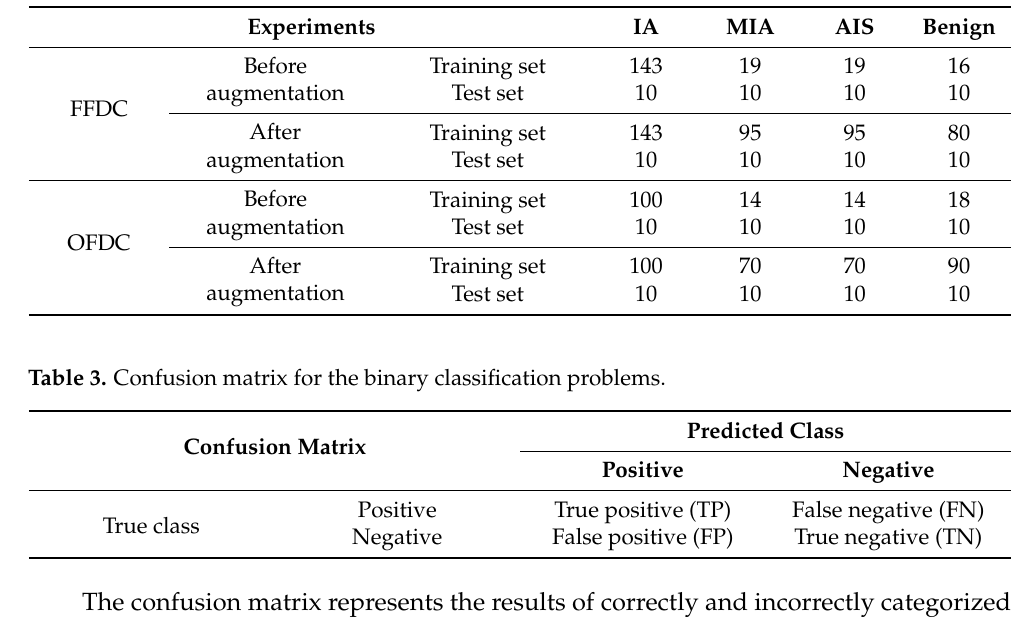
Table 2. The data distribution of augmentation anterior posterior.